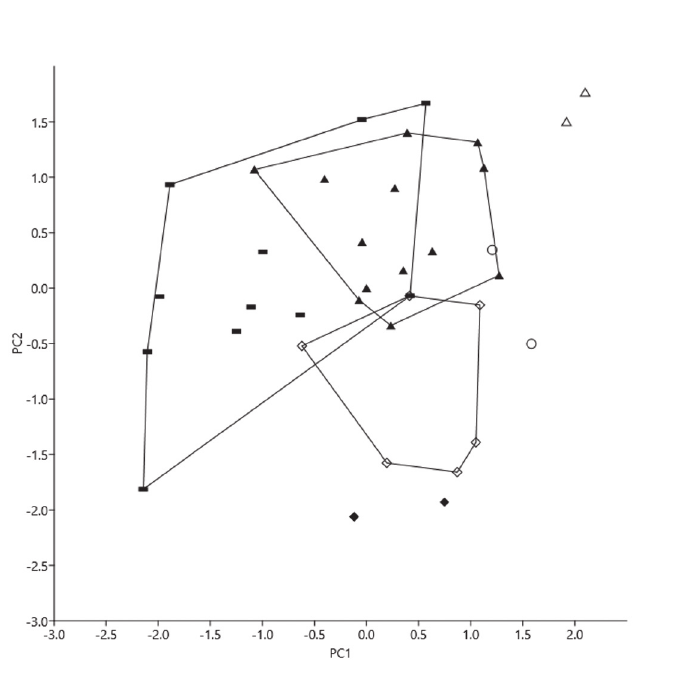
Fig. 8. Scatterplot of PC2 against PC1 for a PCA on 10 meristics (n = 42) of E. cf . atromaculatus (Nichols & Griscom, 1917): Ituri 5 ( ◊ ), Ituri 6 ( ♦ ), Ituri/‘Kisangani region’ ( ∆ ), Epulu 2 ( ▲ ), and Ituri 8 ( ). Also shown are the type specimens of E. atromaculatus (Nichols & Griscom, 1917) ( ○